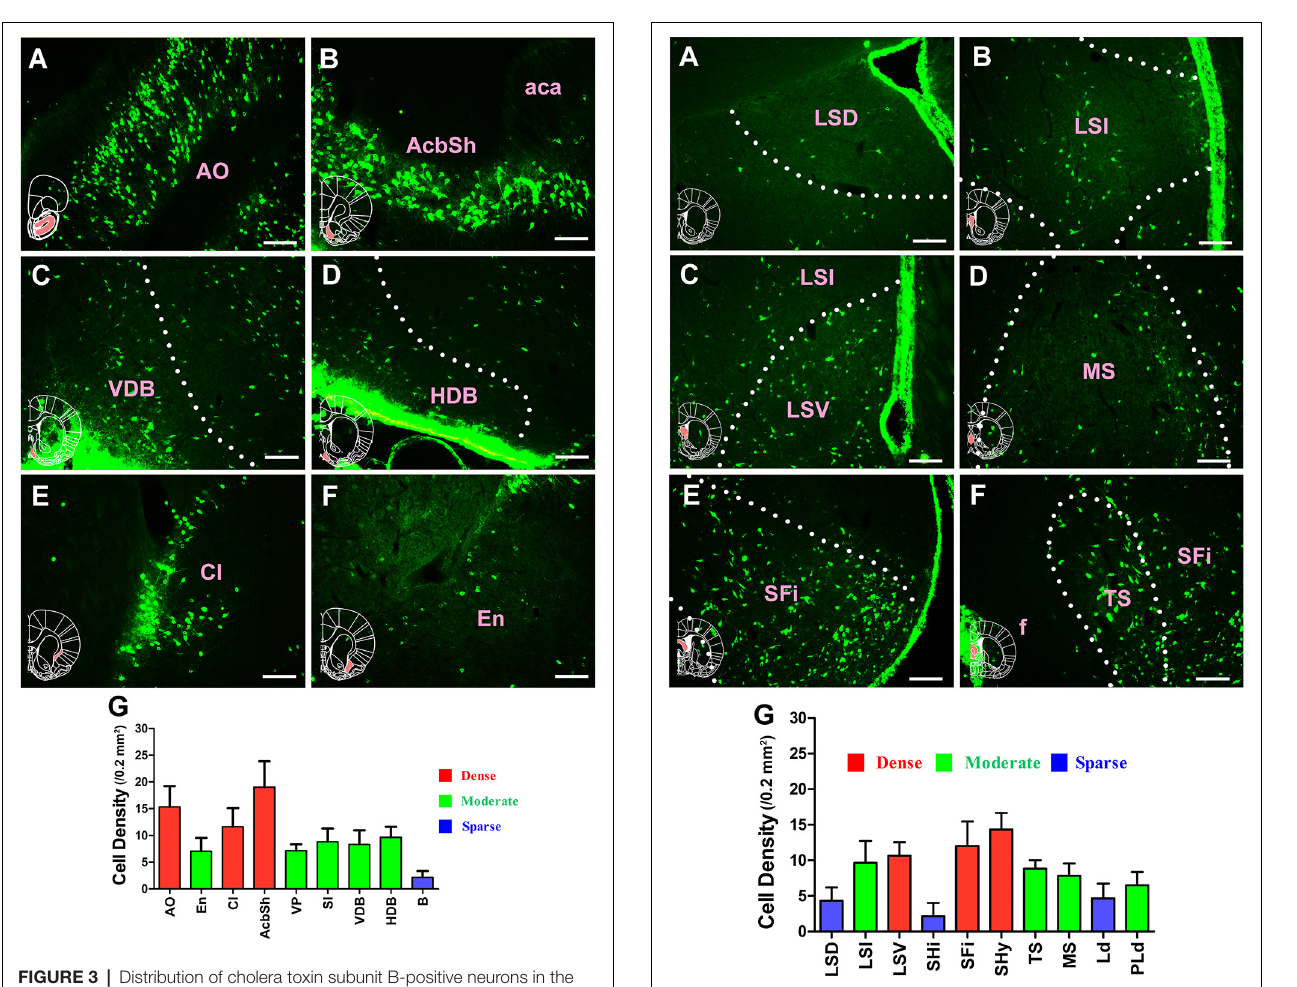
processing (Reznikov et al., 2009; Gratwicke et al., 2013;